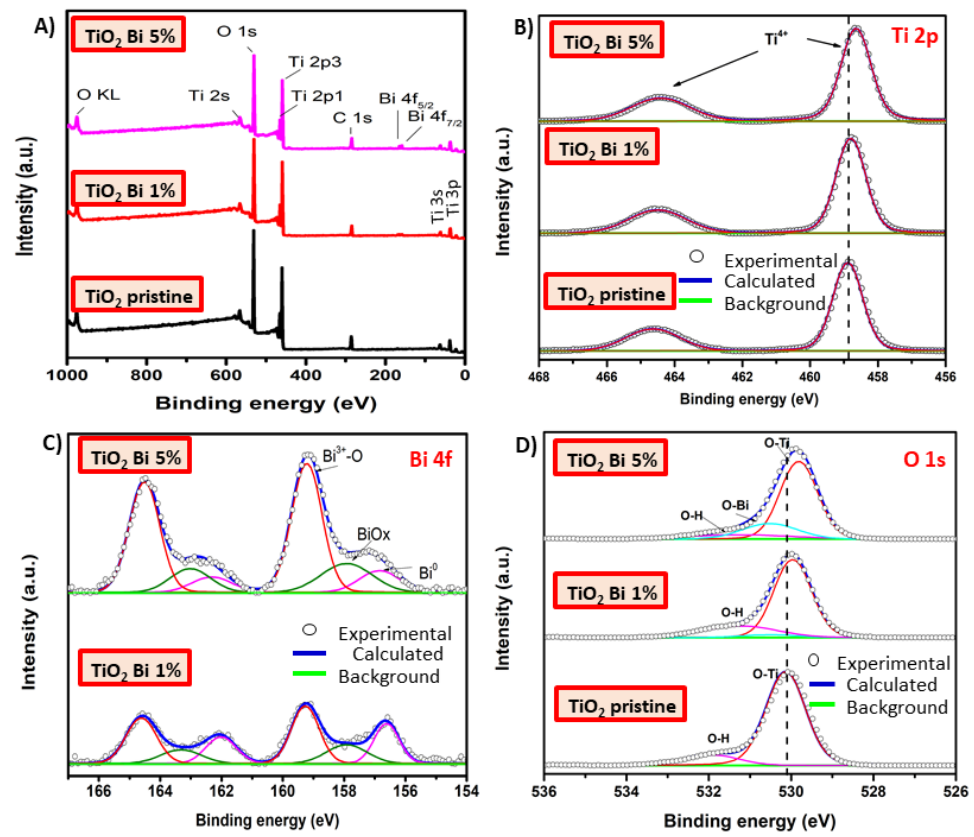
Figure 2. XPS spectra of pristine TiO 2 and Bi-doped TiO 2 samples ( A ). Spectra of Ti 2p ( B ), Bi 4f ( C ), and O 1s ( D ) with deconvolution for pristine TiO 2 and Bi-doped TiO 2 samples. The peaks at 164.6 eV and 159.3 eV for both samples can be ascribed to Bi 4f 5/2 and Bi 4f 7/2 , respectively, corresponding to Bi 3+ , whereas the peaks centered at 163.4 and 158 eV for the TiO 2 Bi 1% sample and the peaks at 163.1 and 158 for the TiO 2 Bi 5% sample are attributed to Bi 4f 5/2 and Bi 4f 7/2 of Bi 4+ . The peaks at 159.3 and 158 eV ascribed to Bi 4f 7/2 are the signals corresponding to Bi 3+ and Bi 4+ , respectively, indicating a partial oxidation of the centers from Bi 3+ to Bi 4+ ; Wang et al., (2016) and Hao et al., (2019) mention that the peaks at 163.7 eV and 164.5 eV, corresponding to Bi 4f 5/2 , and the peaks at 159.2 eV and 158.4 eV, corresponding to Bi 4f 7/2 , are attributed to the oxidized bismuth layers